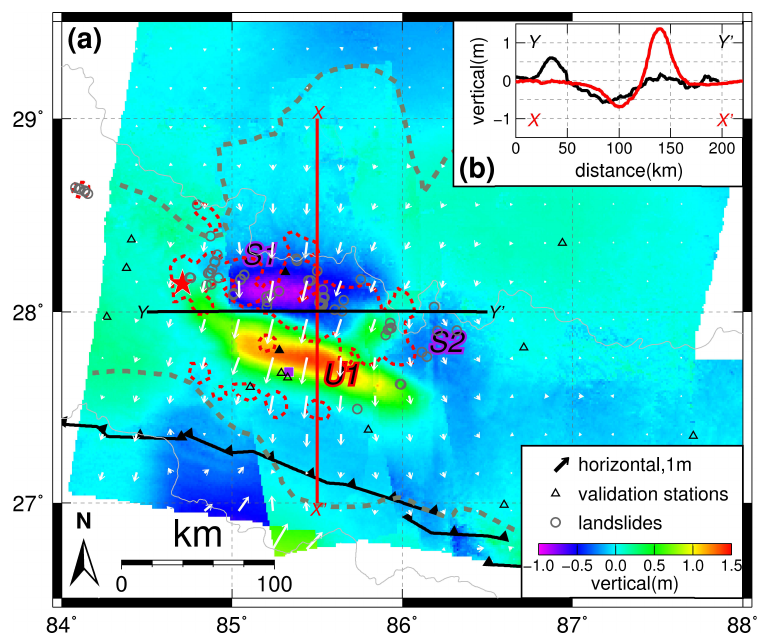
Figure 3. Solutions associated with the 25 April 2015 Gorkha, Nepal, earthquake using ESISTEM approach. ( a ) Three-dimensional surface displacement field. Two subsidence and one uplift zones are marked with “S1”, “S2” and “U1”, respectively. White arrows show the modeled horizontal displacements and are every 20 km. Grey dashed lines delimit the region that modeled displacements have high accuracy, and red dashed lines outline the zones with significant landslides [2]. Thick black lines represent the Main Frontal Thrust (MFT) [12,13]. The red star represents the epicenter of the earthquake, and the purple square the city of Kathmandu. Other symbols are shown in the legend.